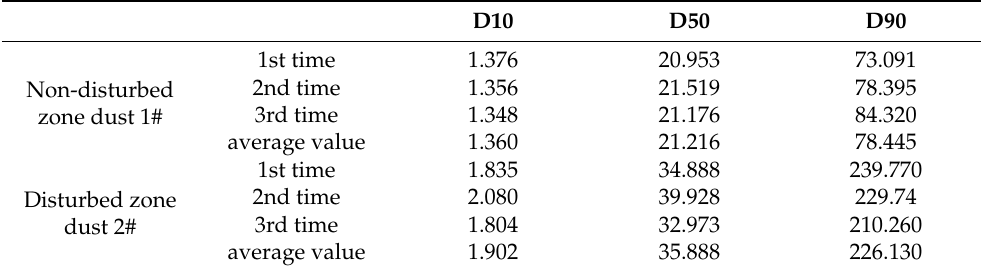
Table 1. Particle size corresponding to dust volume distribution ( µ m).